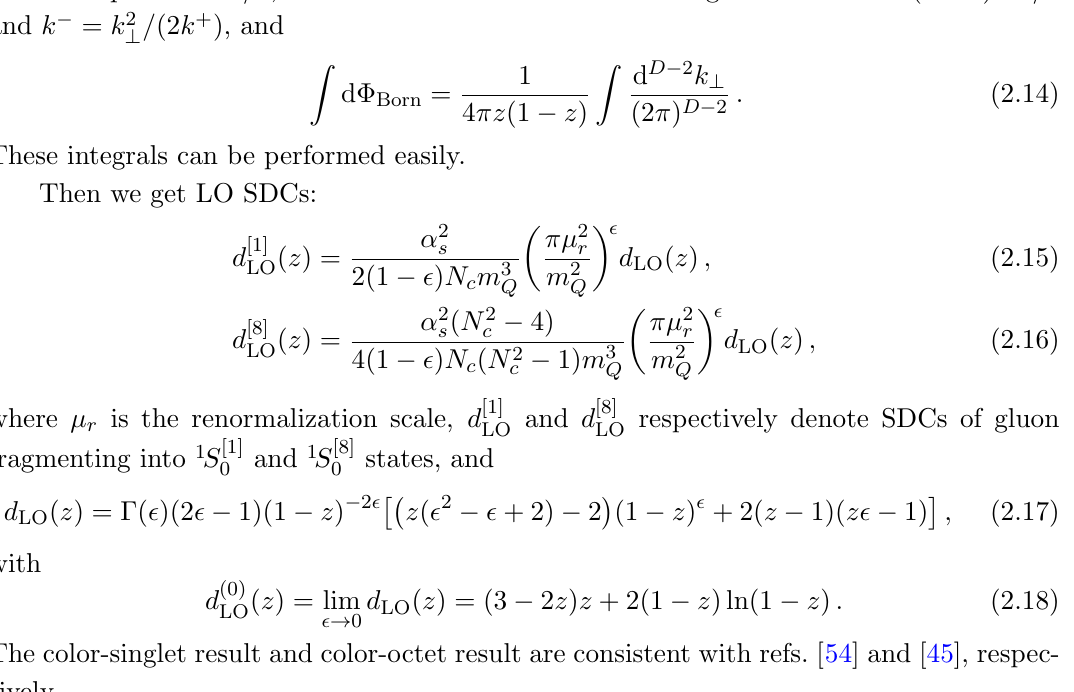
where a equals 0 or 1 = 2, k is the momentum of the emitted gluon with k + = (1 (cid:0) z ) P +